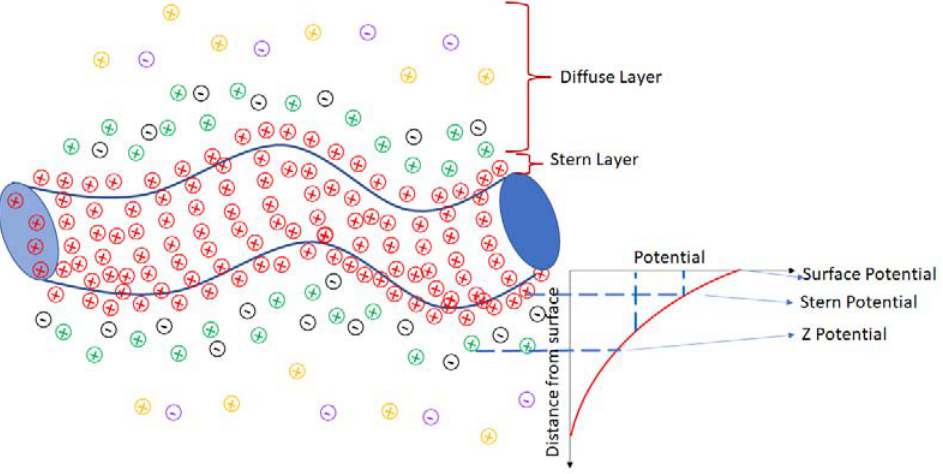
Figure 5. Schematic representation of the zeta potential for nanotubes. The plus and minus signs represent the positive and negative charges, respectively. Colors of charges represent the potentials (charges from surface potential are red; charges from stern potential are green and black; charges from Z ‐ potential are yellow and purple).